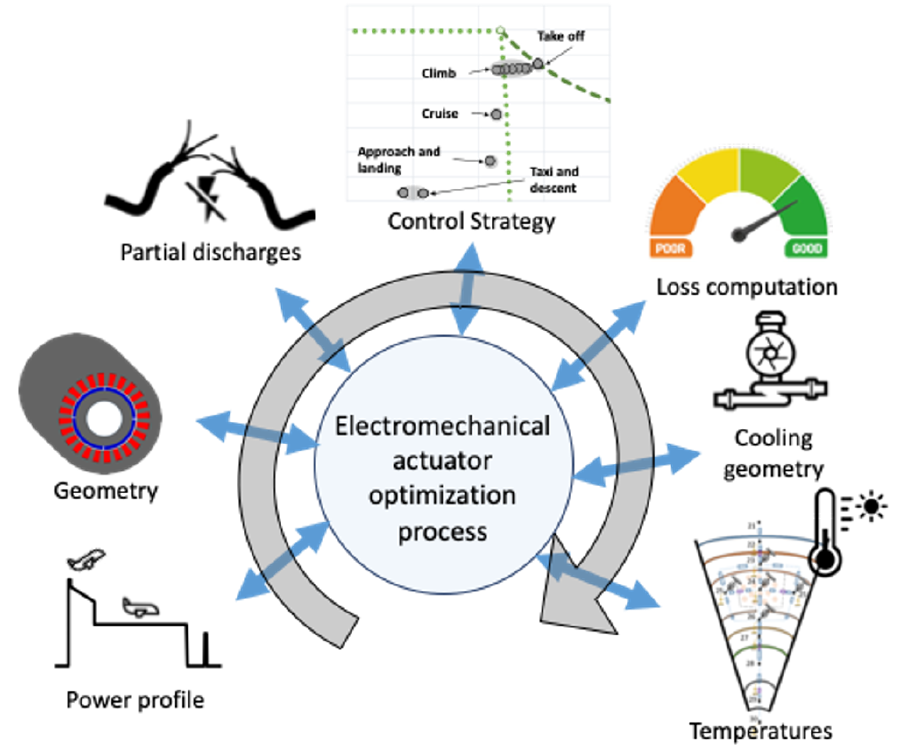
Figure 3. MDO process for electromechanical actuator optimization.